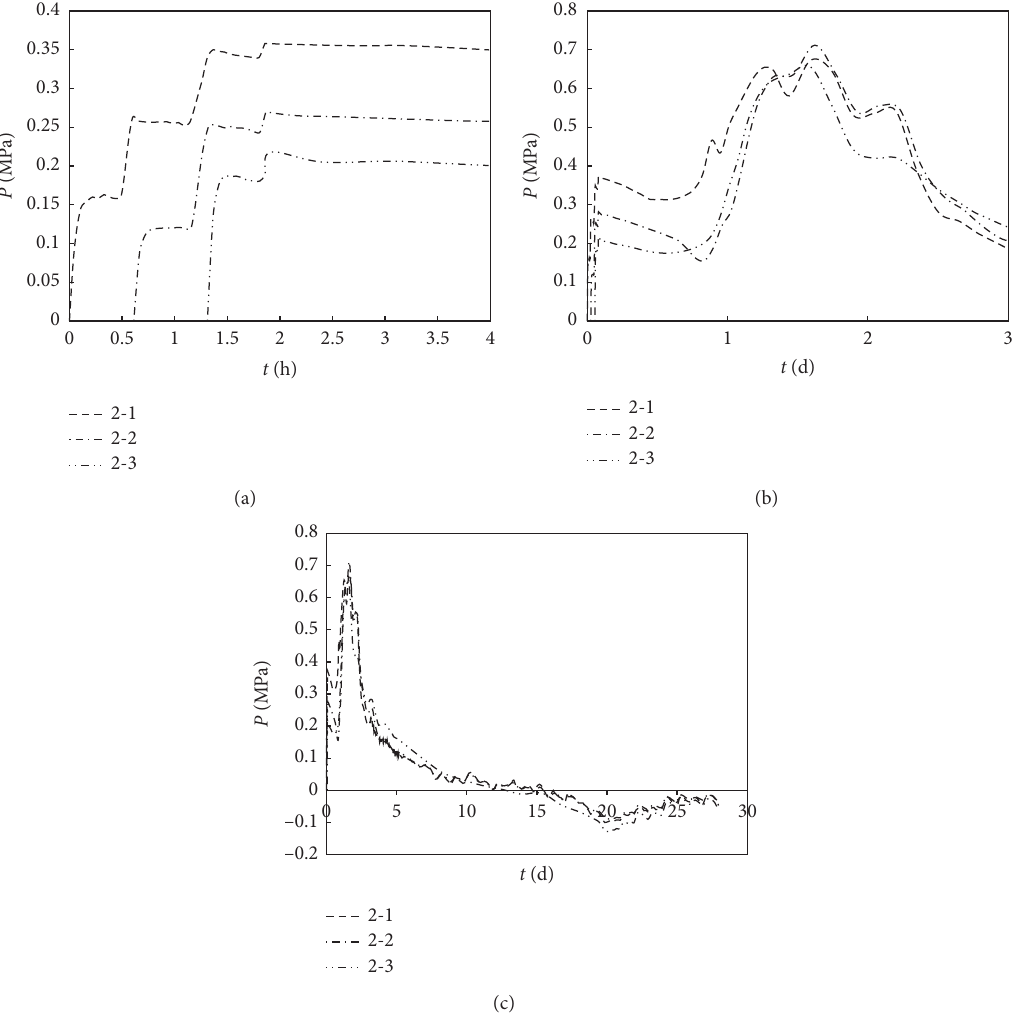
Figure 8: Test curves of pouring pressure and expansion stress of the core concrete for SYZ-2. (a) 4 hours. (b) 3 days. (c) 28 days.